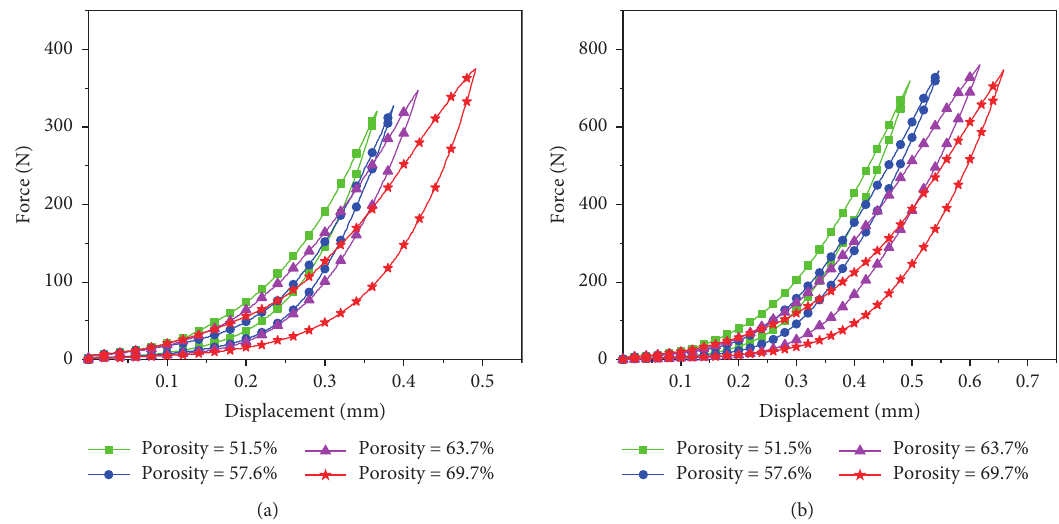
Figure 9: Comparison diagram of the influence of porosity on compression performance. (a) Static loading � 400N. (b) Static loading � 800N. Table 1: Change of loss factor and energy dissipation with porosity. Porosity (%) Loss factor